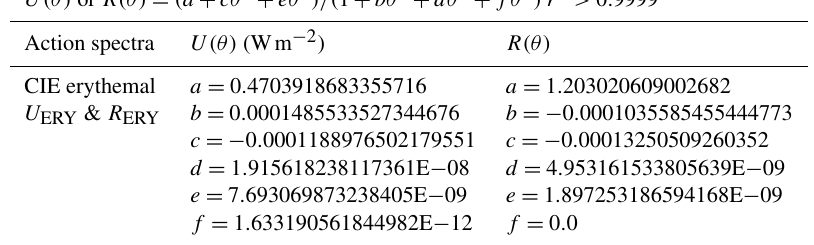
Table A1. Coefficients R(θ) and scaling coefficient U(θ) for 0 < θ < 80 ◦ and 100 < (cid:127) < 600DU for E((cid:127),θ) = U(θ)((cid:127)/ 200 ) − R(θ) (1.0E10 = 1.0 × 10 10 )